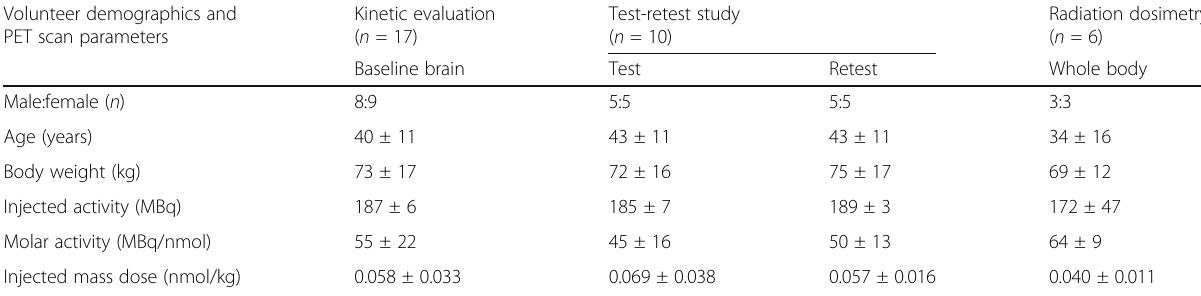
Table 1 Demographic characteristics and PET scan parameters for 17 healthy volunteers injected with [ 18 F]LSN3316612 Volunteer demographics and PET scan